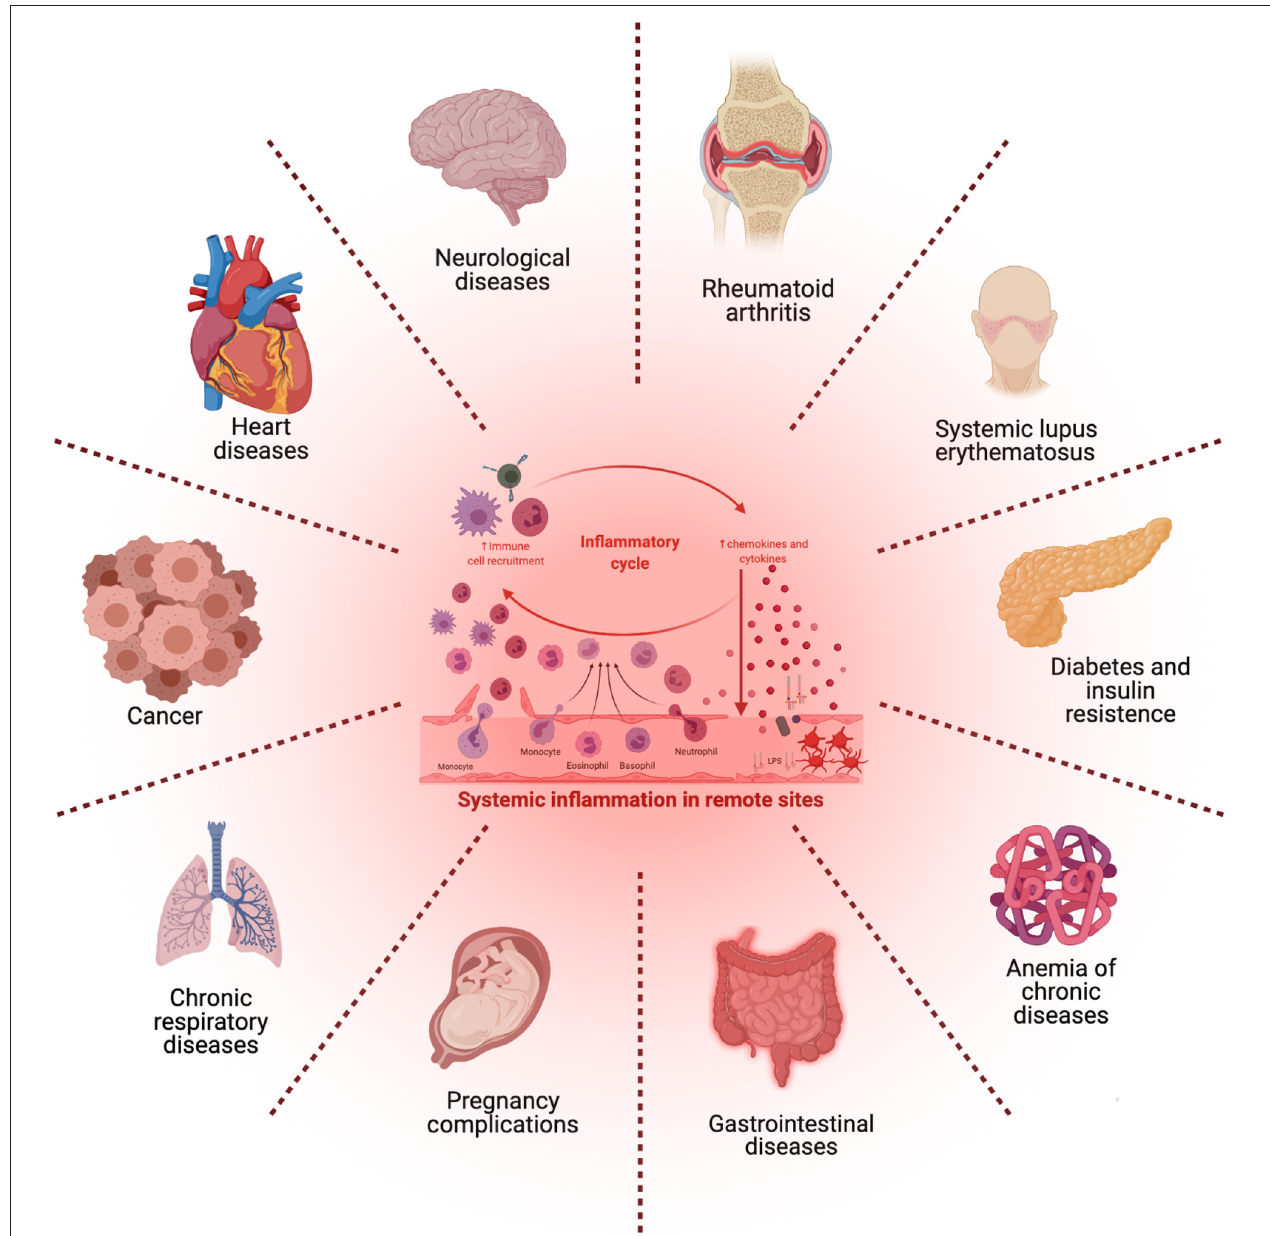
FIGURE 3 | Microbial imbalance, irregular immune response, and chronic periodontitis may exert systemic or distant effects and could lead to the activation of other disorders that share common inflammatory pathways. [Figure generated with BioRender